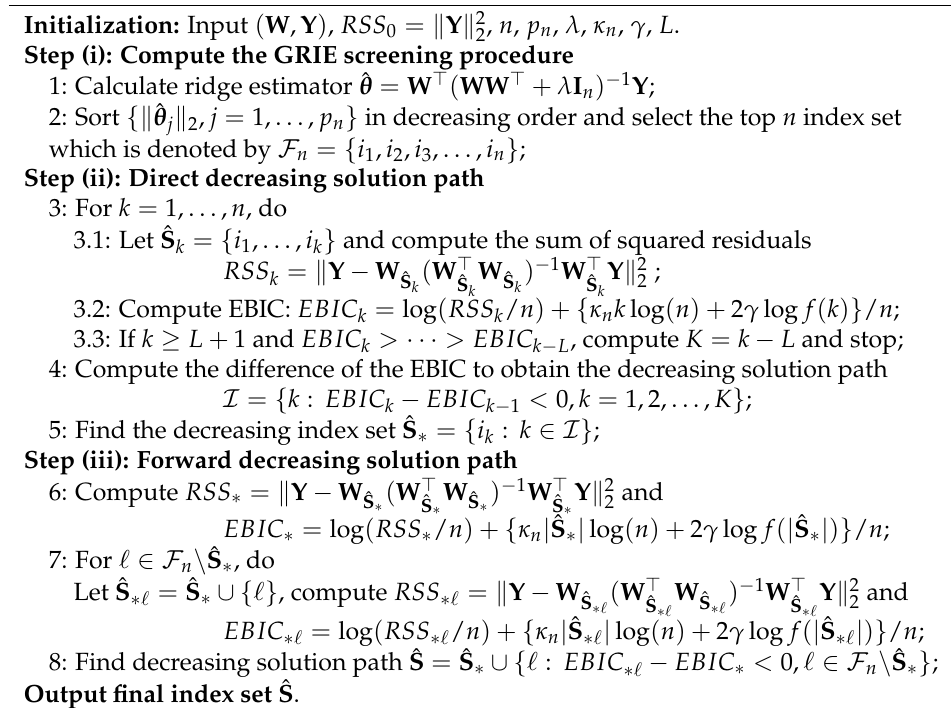
Algorithm 1 GRIE-EBIC